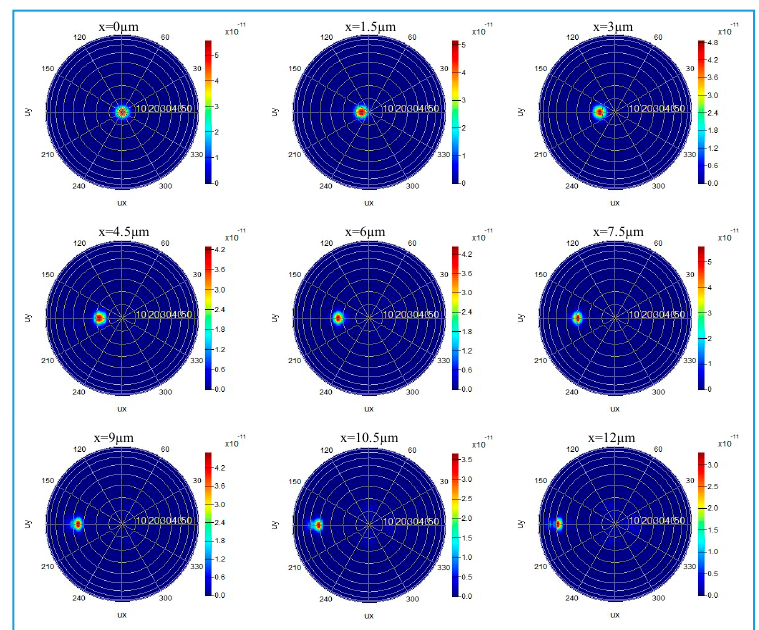
Figure A5. Intensity distribution of the reflected light in the coordinate system of inclination angle and azimuth angle. The Gaussian source is localized on the focal plane with coordinates (0–12 µm, 0, 15 µm), which is reflected by the meta-reflector with Au film in Figure 5a.